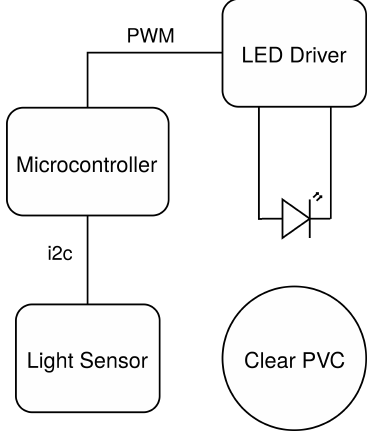
Figure 7. Low-cost continuous turbidity monitoring system